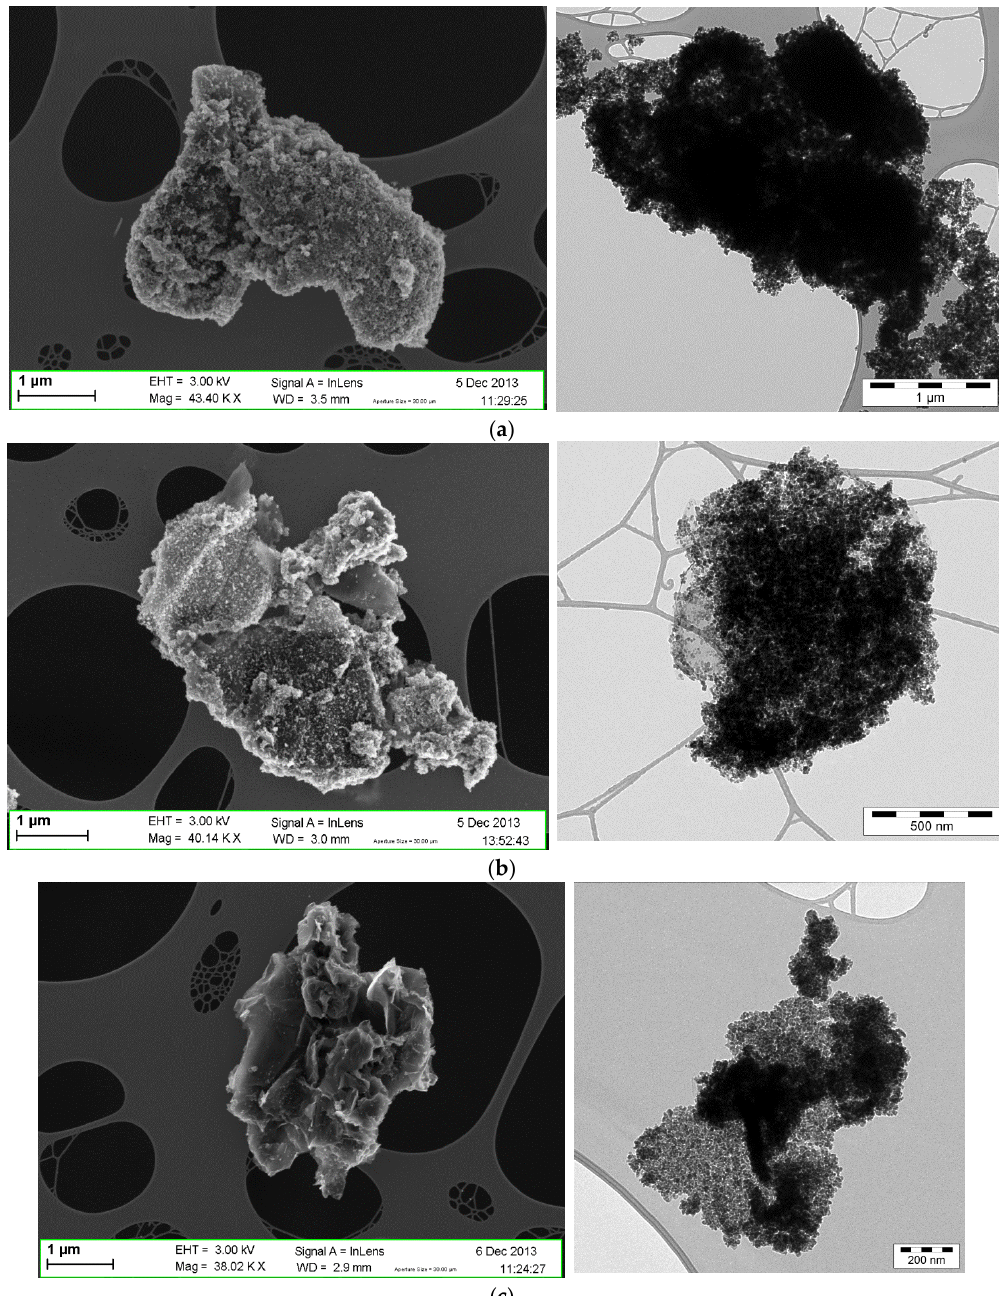
Figure 8. SEM (left column) and TEM (right column) images of Fe 3 O 4 @GO nanocomposites produced via the solvothermal method [16] at 50% ( a ), 30% ( b ) and 10% ( c ) Fe/NCS loading rate. The MNPs spatial distribution was also affected by the presence of oxygenated functions on the NCS surface. This effect was clearly observed when decorating pristine and oxidized MWCNTs using the solvothermal method at a 10% weight ratio (Figure 9). Indeed, smaller MNPs distributed along the MWCNTs surface when these were previously oxidized contrasted with only larger particle agglomerates found within the pristine MWCNT-supported samples. These results prove that the NCS oxygenated surface functions are serving as nucleation sites during the formation and growth of